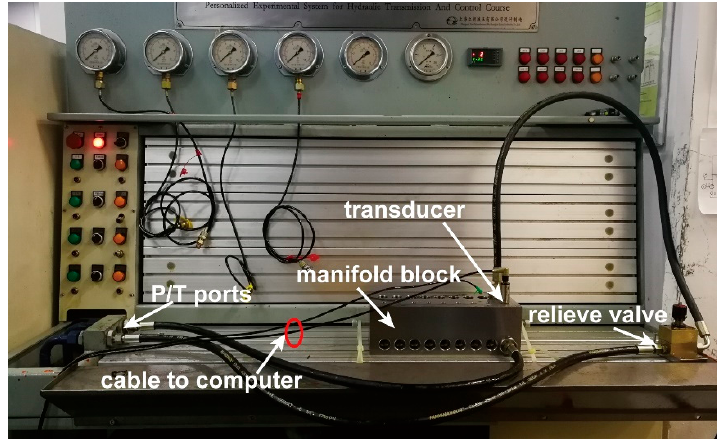
Figure 5. Test rig and connections.